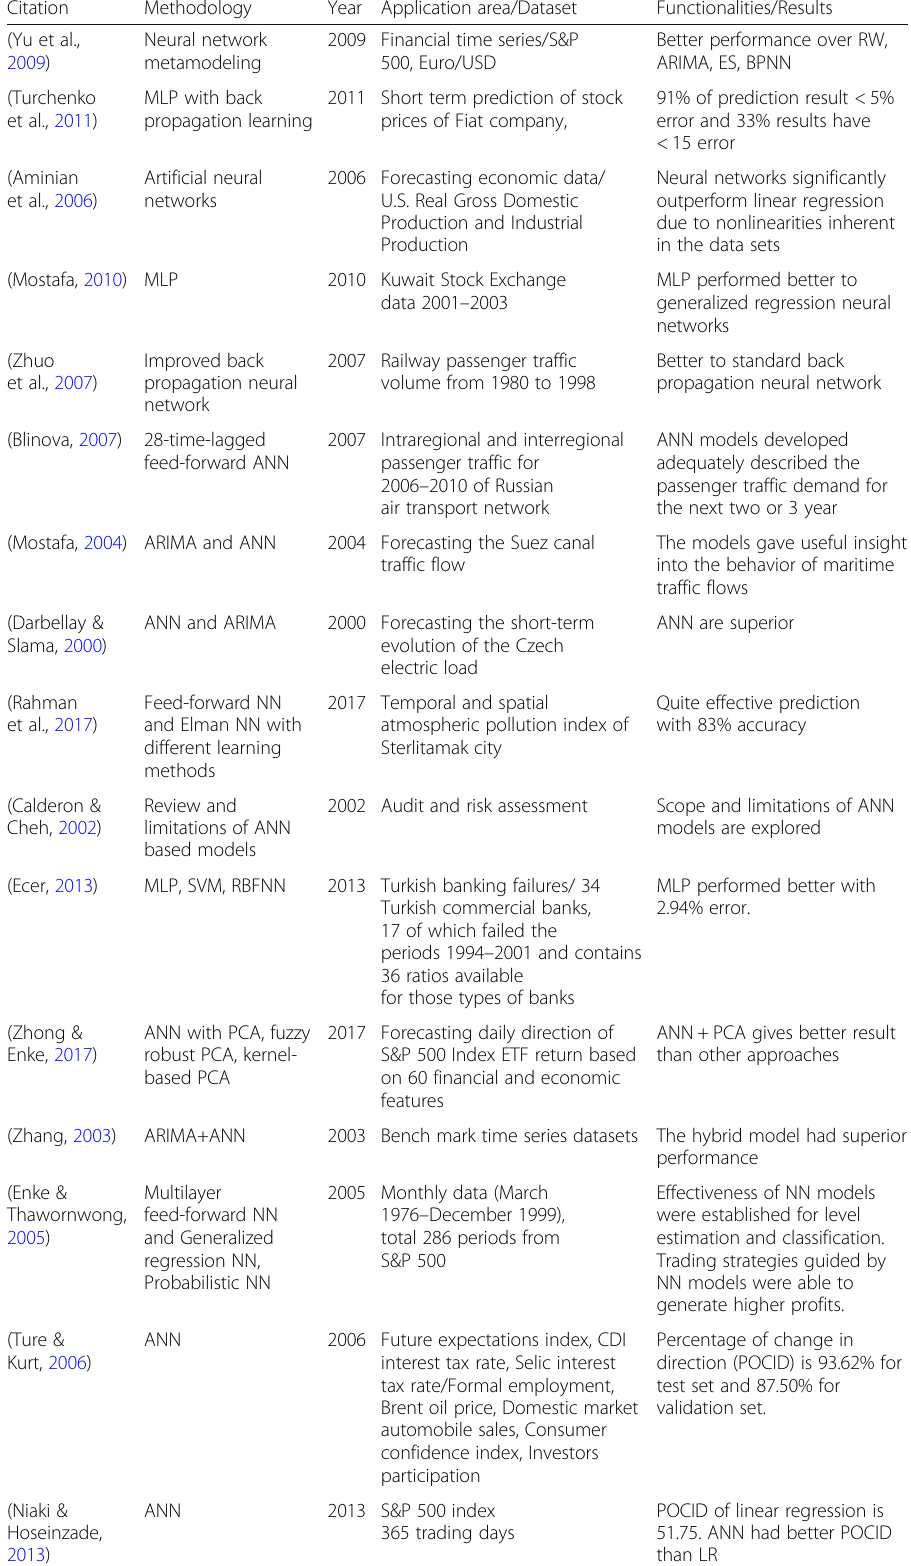
Table 1 Review of ANN articles on financial time series